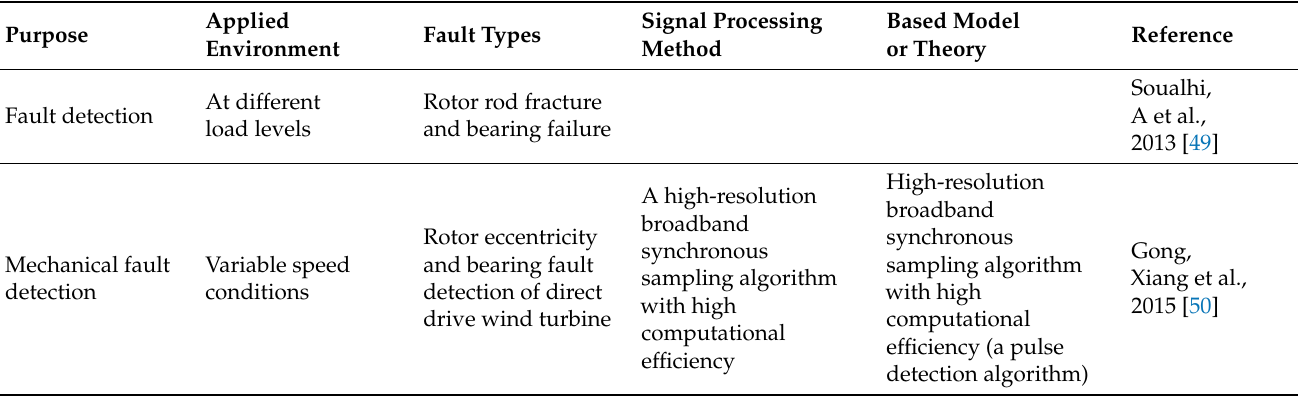
Figure 4. The method of combining information theory measurement and intelligent tool detection. The above methods can be seen in Table 4. Table 4. Summary and comparison table of artificial intelligence signal analysis methods.